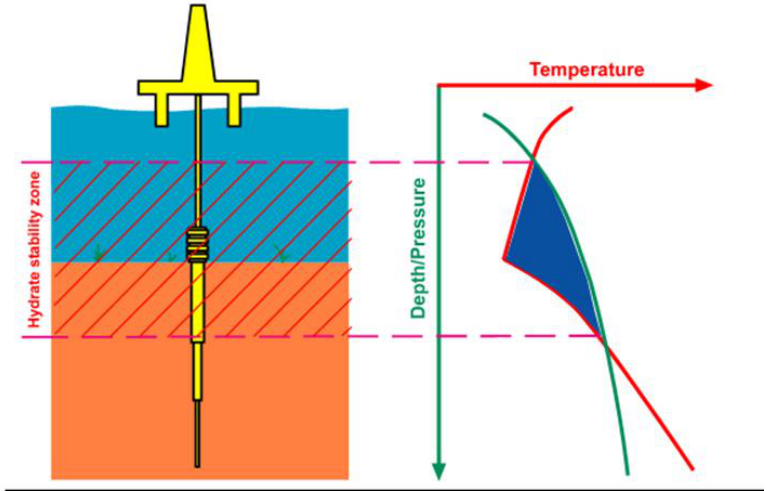
Figure 4. Temperature and pressure curve of natural gas hydrate production [This figure was modified with permission from ref [99]. Copyright 2017, Deng, Z. et al.].